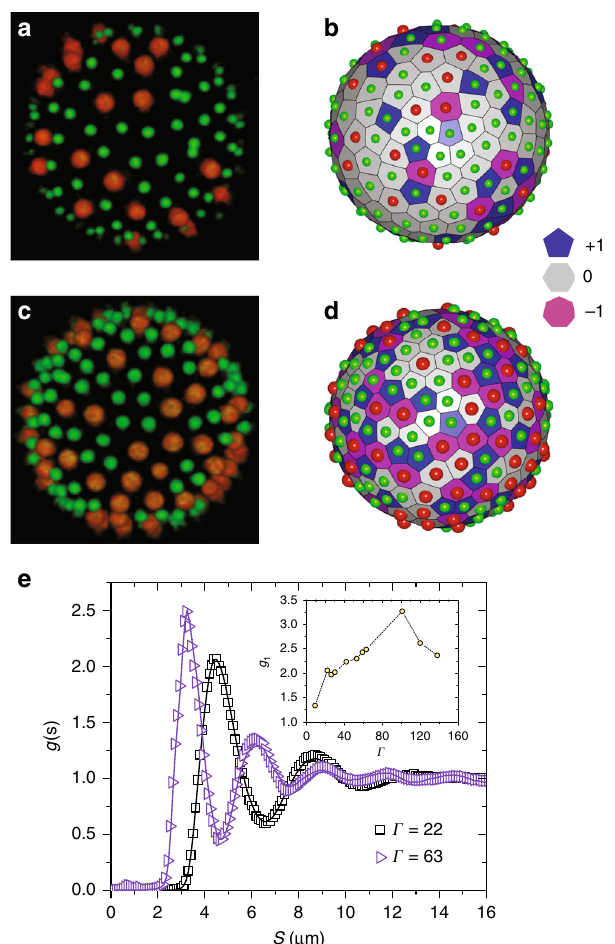
Fig. 1 Static structure of supercooled liquids on a sphere. a , c 3D Confocal micrographs of bidisperse colloidal liquids wrapped on the surface of S 2 at two areal densities. The red and the green colors represent big and small particles which are of radius σ b = 0.908 μ m and σ s = 0.755 μ m, respectively. b , d Radical Voronoi tessellations of particle packings shown in ( a ) and ( c ). Blue, gray, and magenta polygons are associated with 5, 6, and 7 coordinated particles, respectively. These Voronoi tessellations show a disordered phase with topological defects uniformly covering the surface. e Pair-correlation function g ( s ) as a function of the geodesic distance s for Γ = 22 (black open squares) and Γ = 63 (violet open triangles), displaying liquid-like short-range order. The lines are hypernetted — chain (HNC) fi t to the data, indicating good agreement between theory and experiment. Inset to ( e ) shows nonmonotonic evolution of the height of the fi rst peak ( g 1 ) of g ( s ) as a function of Γ